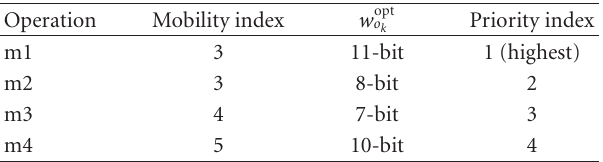
Table 1: Priority list of multiplication operations with mobility index and spatio-optimal